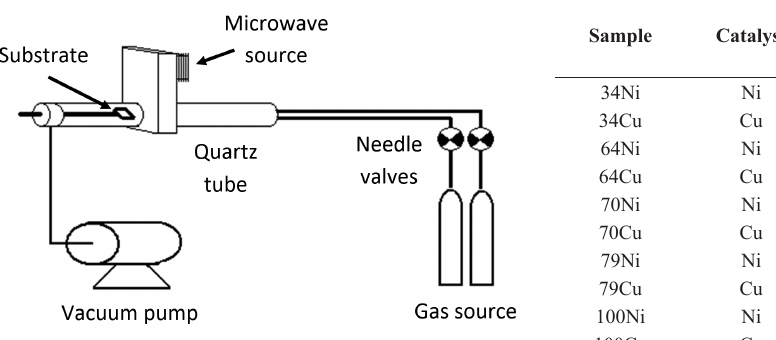
Figure 1. Schematic representation of the PECVD system.